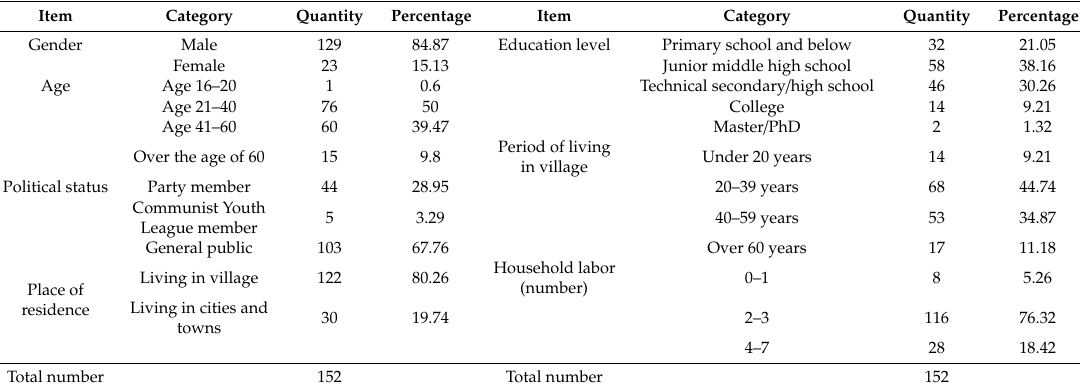
Table 1. Descriptive statistics.